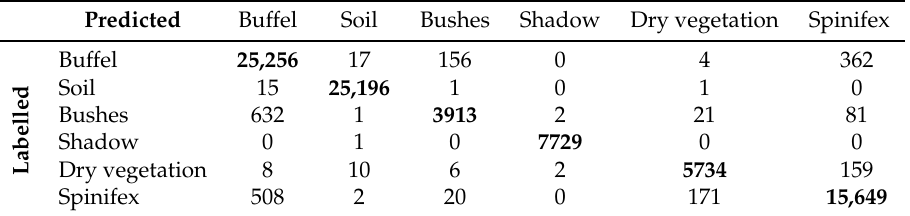
Table 1. The eXtreme Gradient Boosting (XGBoost) classifier confusion matrix.